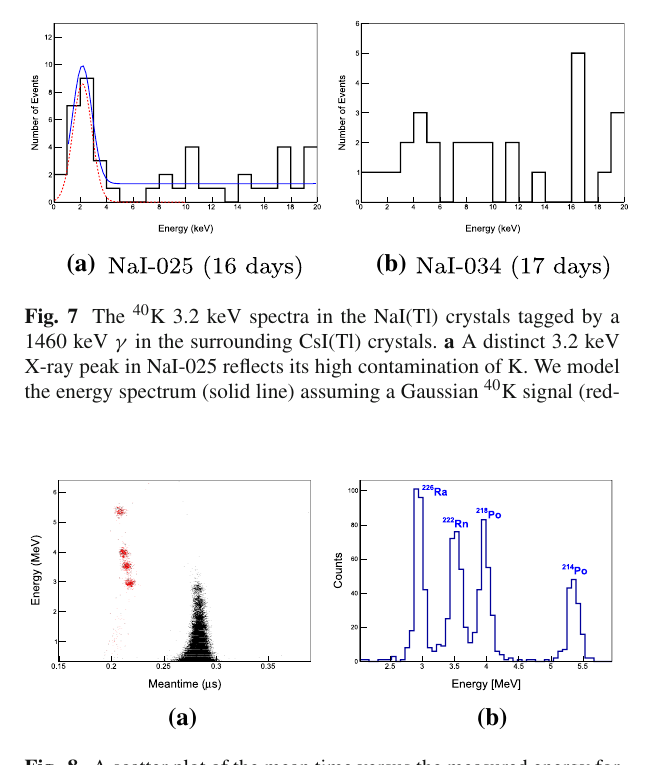
Fig. 8 A scatter plot of the mean time versus the measured energy for the NaI-036 crystalwith16 days exposure is shown ( a ). Here α -induced events (red dots) are well separated from β or γ -induced events (black dots). b The energy spectrum of the selected α -induced events is shown; each peak represents a specific daughter alpha decaying component from 226